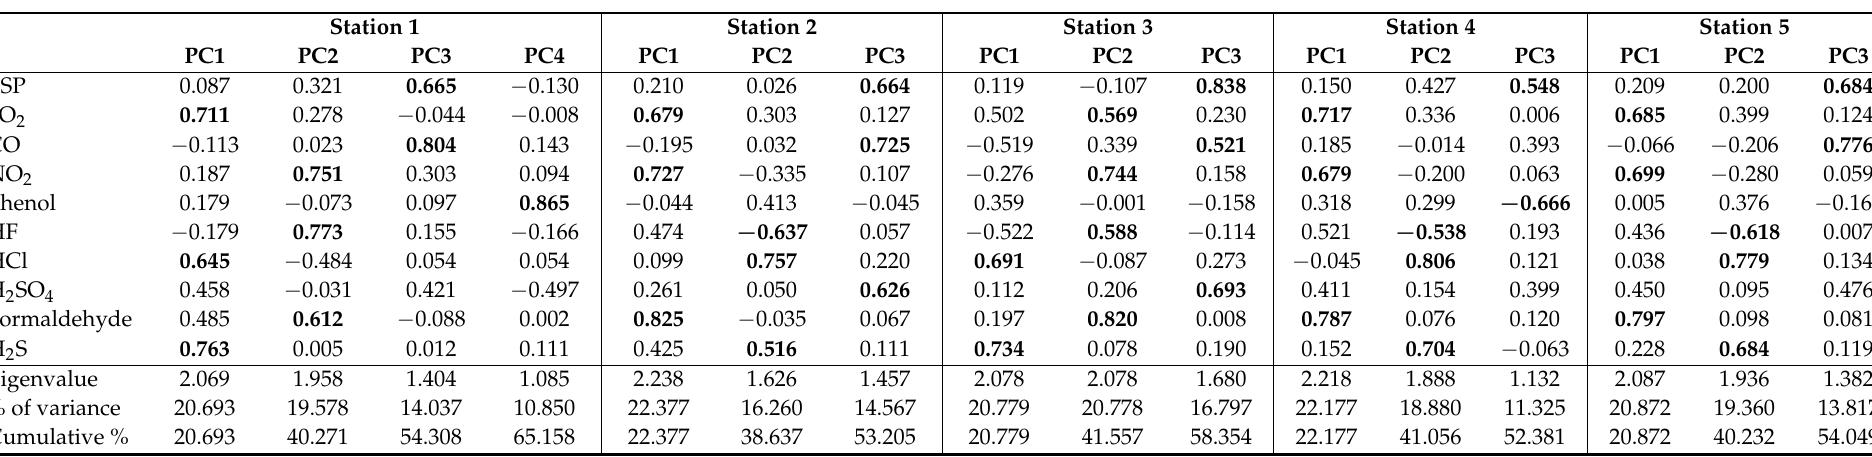
Table 5. Principal Component Analysis for the warm